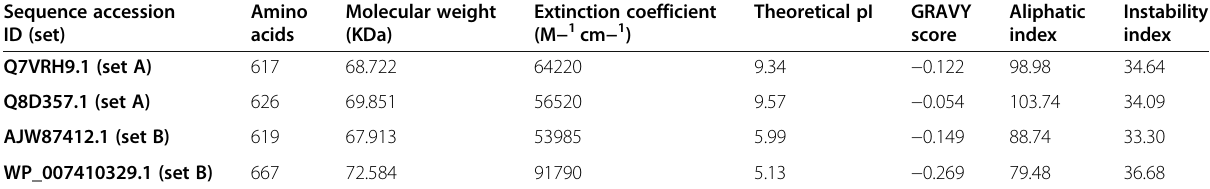
Table 1 Physicochemical parameters, estimated by ProtParam, indicating a substantial variation for certain features Sequence accession ID (set)